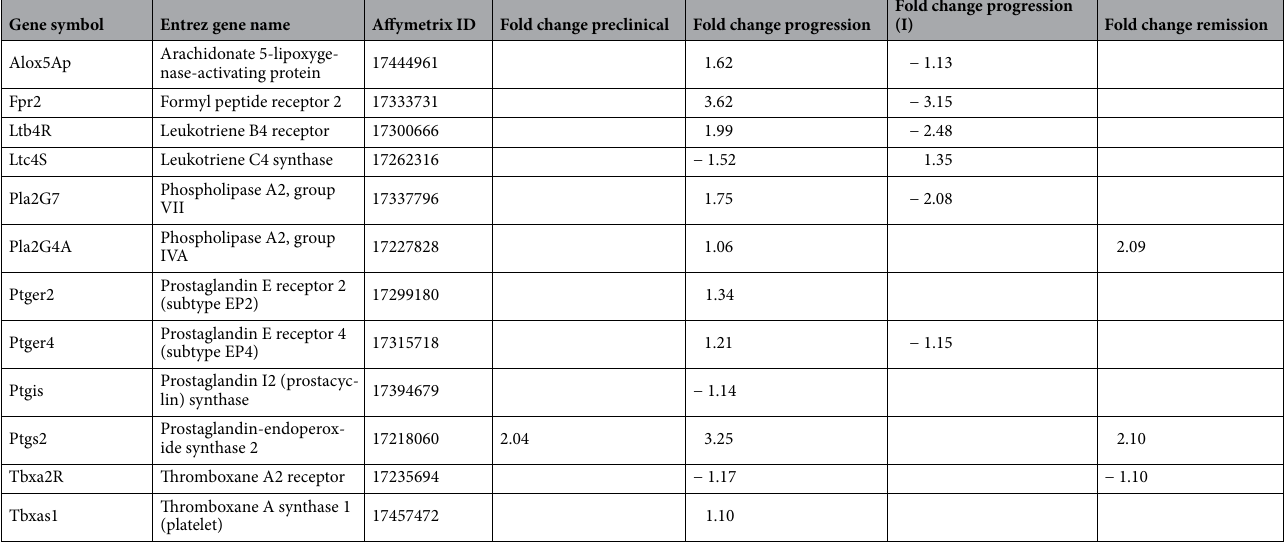
Table 1. Differentially expressed immune mediators in the BBB transcriptome during the preclinical, progression and remission phase of EAE. Differentially expressed genes between naïve mice and MOG-EAE induced mice during preclinical, progression and remission phase as well as from imatinib compared to PBS treated mice during the progression phase, respectively. An adjusted P value lower than 0.05 and a log2 fold change >1 was used as statistical cut off except for the transcript indicated with # (adjusted P value 0.06). Fold change progression (I) refers to the comparison of imatinib versus PBS treated mice during the progression